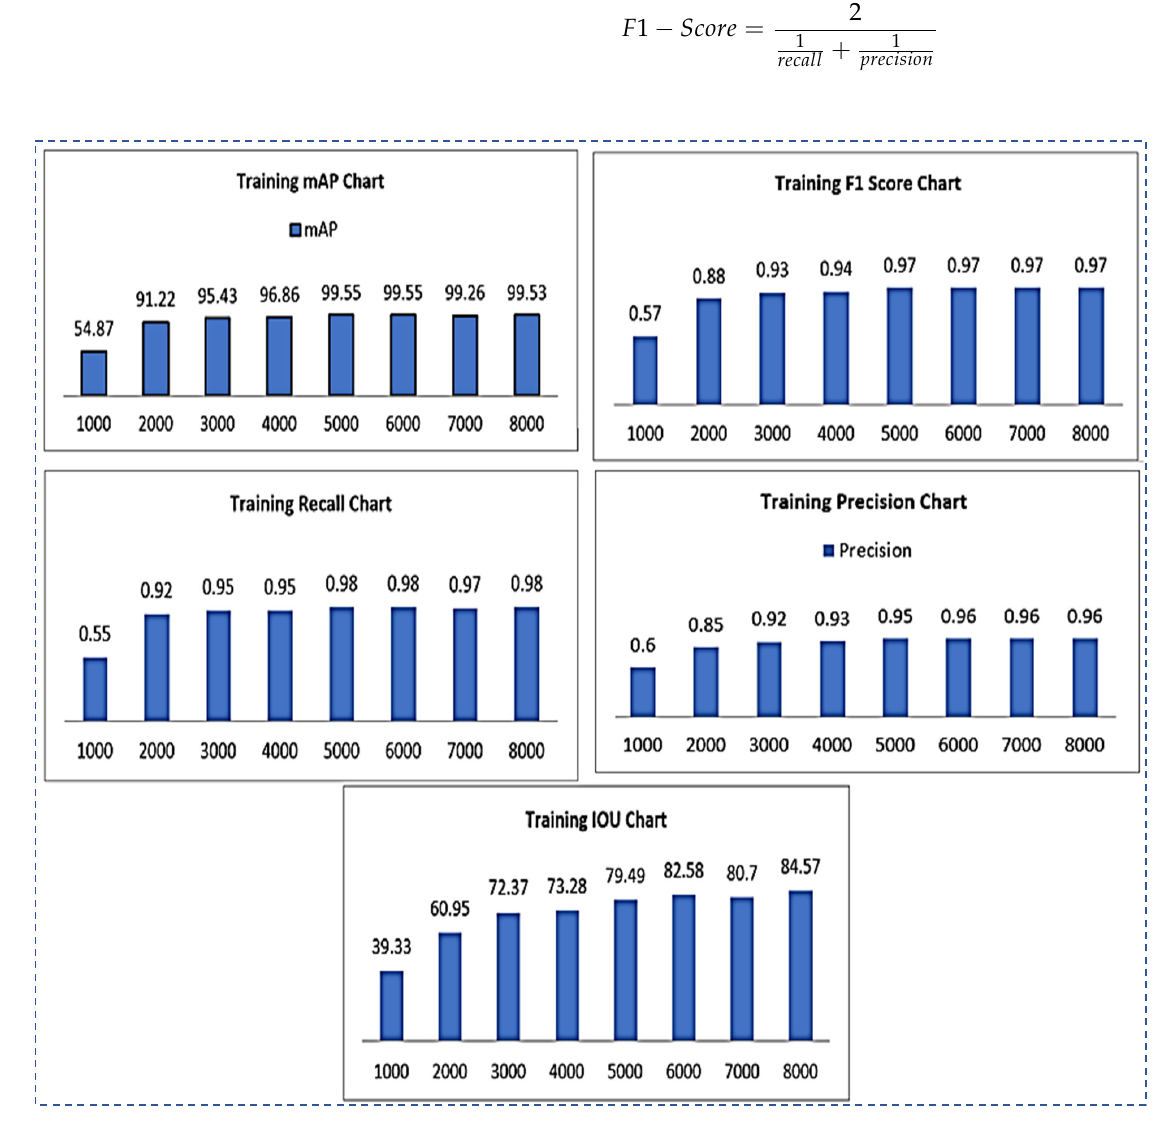
Figure 6. Training results chart representation for mAP, F1 ‐ Score, recall, precision, IOU. Results of all the training parameters such as F1 ‐ score, recall, IOU, precision, and map on the total of 8000 iterations are given in Table 5. Table 5. Training results of F1 ‐ score, recall, IOU, precision, mAP.